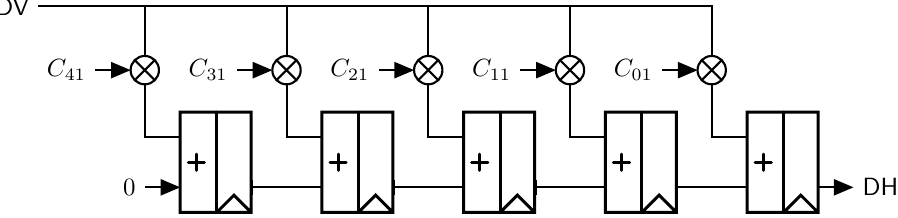
Figure A2. The horizontal filter implemented with a Transpose structure which takes the output of the column vector operation, DV, and produces DH in its